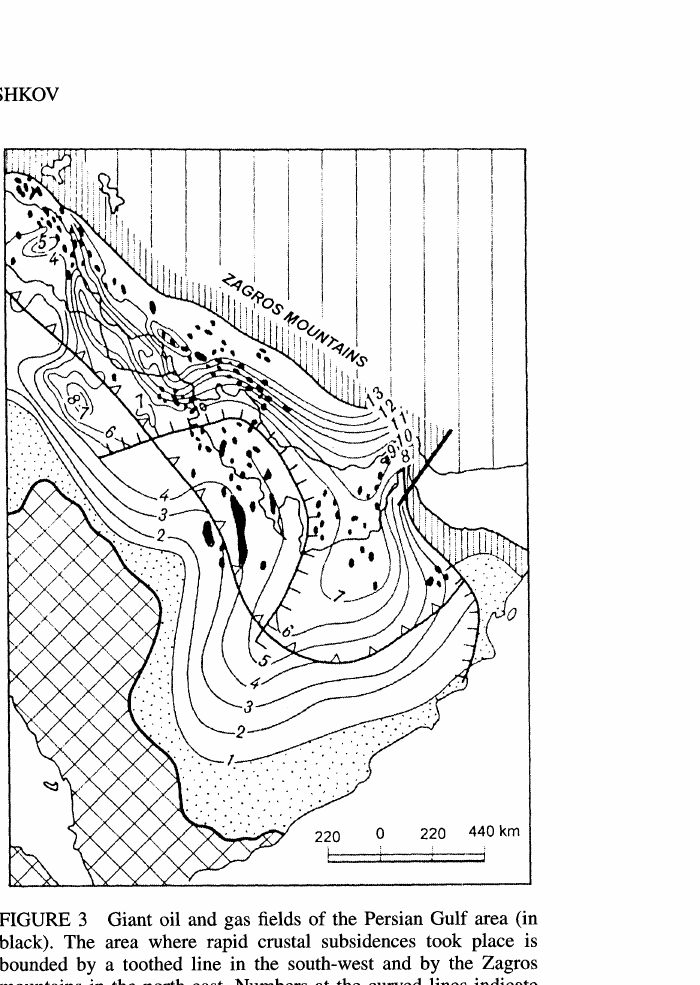
FIGURE 3 Giant oil and gas fields of the Persian Gulf area (in black). The area where rapid crustal subsidences took place is bounded by a toothed line in the south-west and by the Zagros mountains in the north-east. Numbers at the curved lines indicate the thickness of sediments (km). Hydrocarbon fields predominantly occur within the area of rapid subsidence. Only three fields are located outside this area near to its south-western boundary. They could be formed due to a lateral migration of hydrocarbons from the areas of rapid